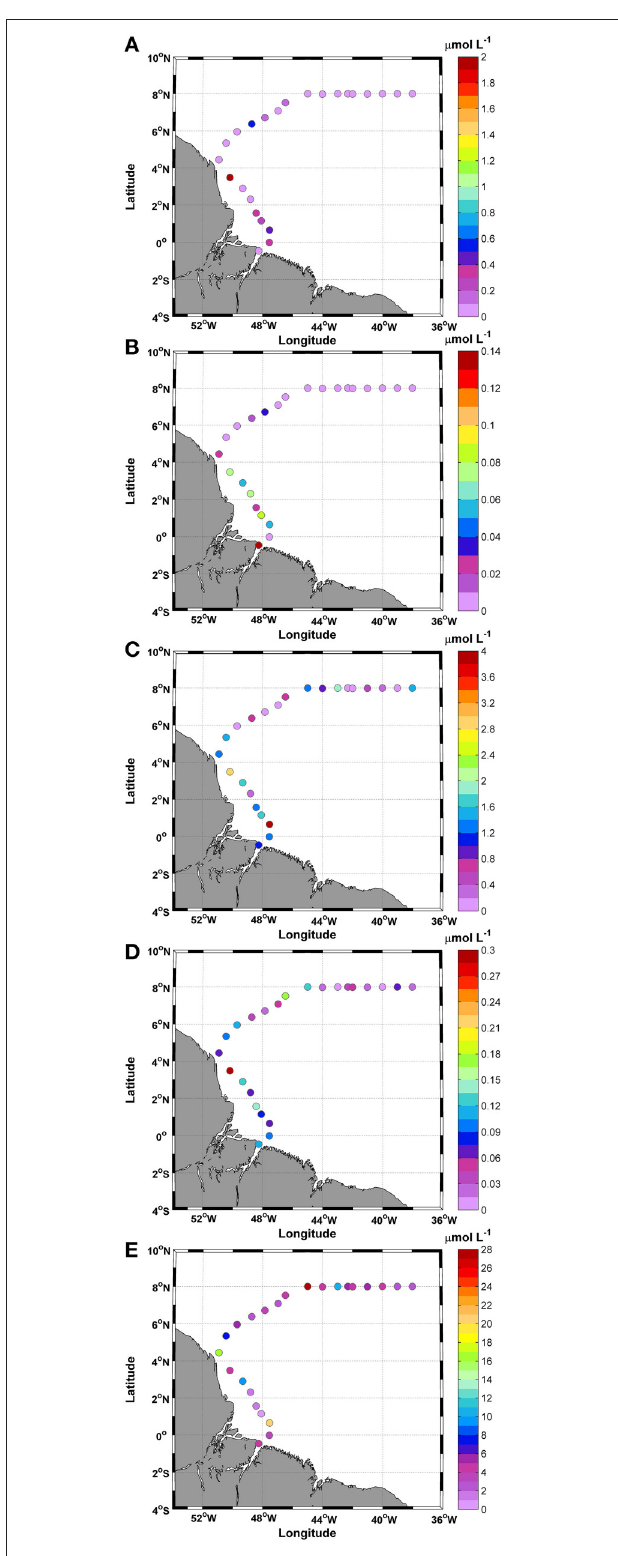
FIGURE 3 | Distributions of (A) Ammonia; (B) Nitrite; (C) Nitrate; (D) Phosphate; and (E) Silicate along the ship track during the CF3 cruise, October